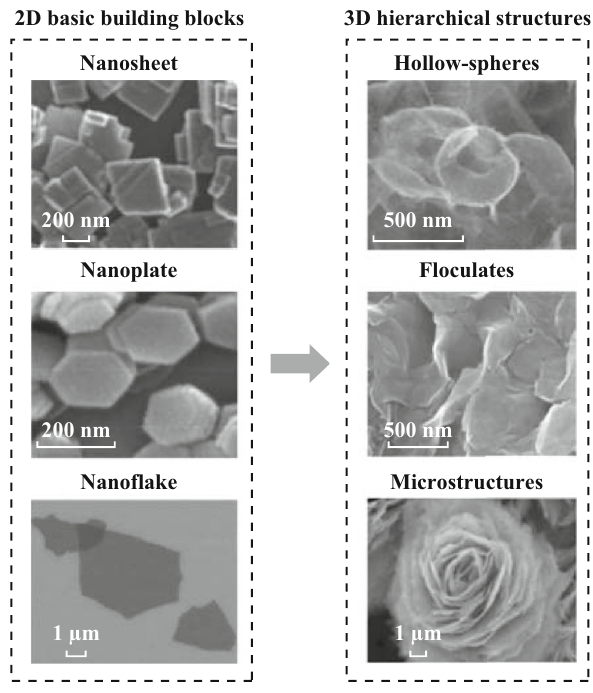
Fig. 3 Representative scanning electron microscopic images of the 2D basic building blocks and common 3D hierarchical